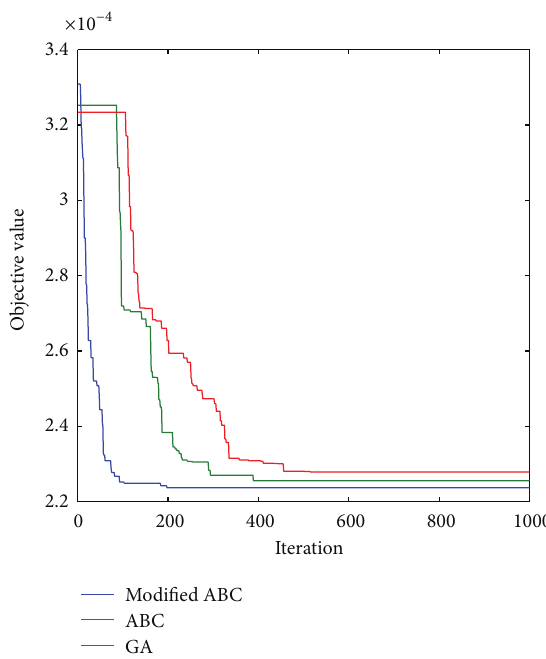
Figure 3: Convergence characteristics of the modified ABC, ABC, and GA (𝑢 0 = 0.08 , ℎ 0 = 1.8) .